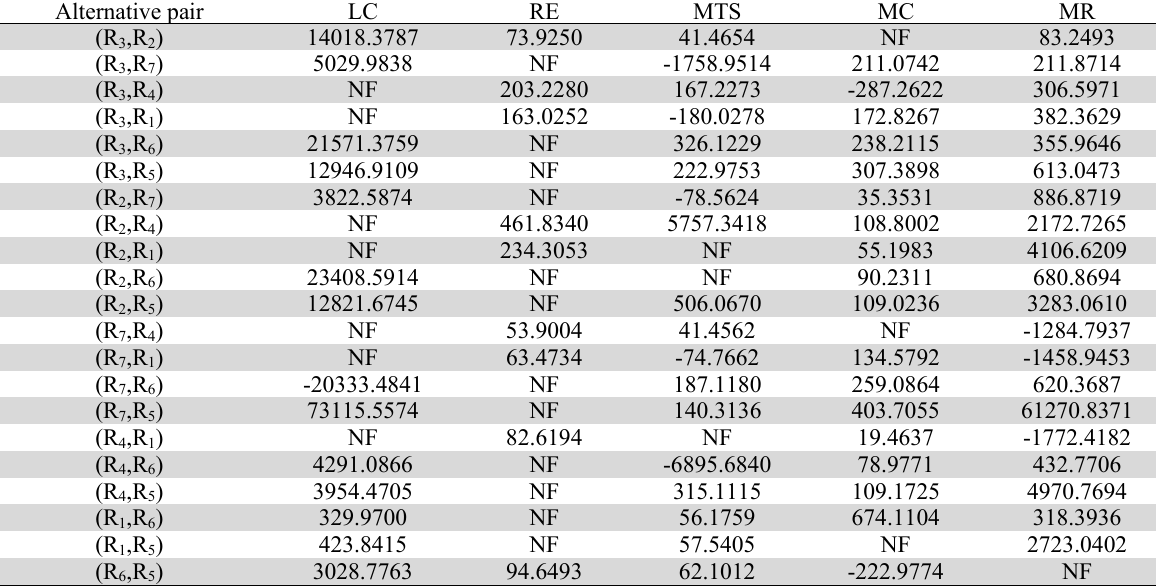
δ ' k,i,j values for robot selection Example 1 Alternative pair